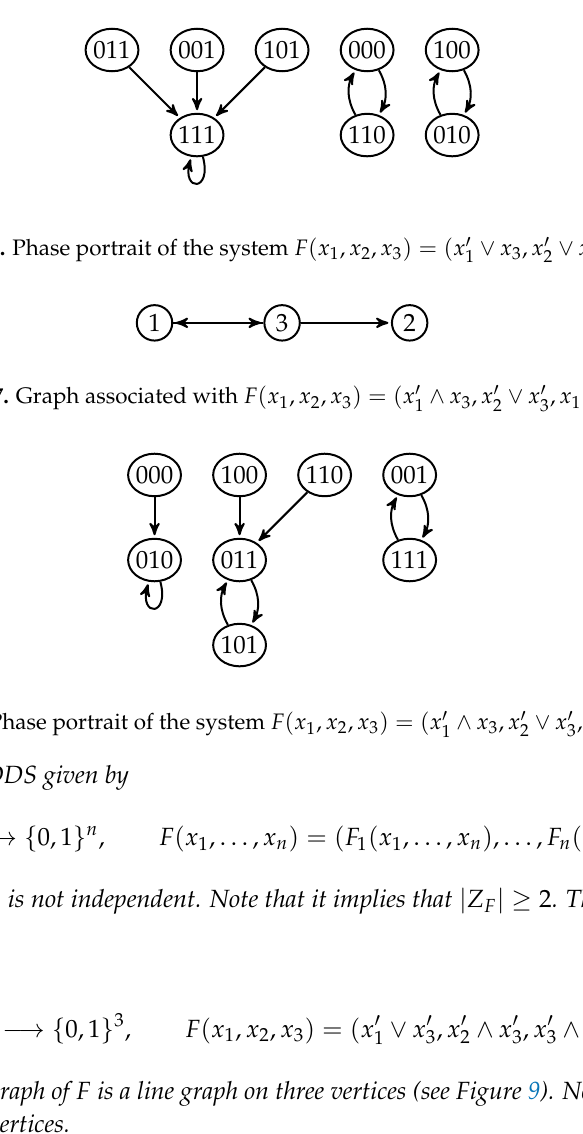
(cid:48) ∨ x ∨ x ) . 3 , x 3 , x 3 2 1